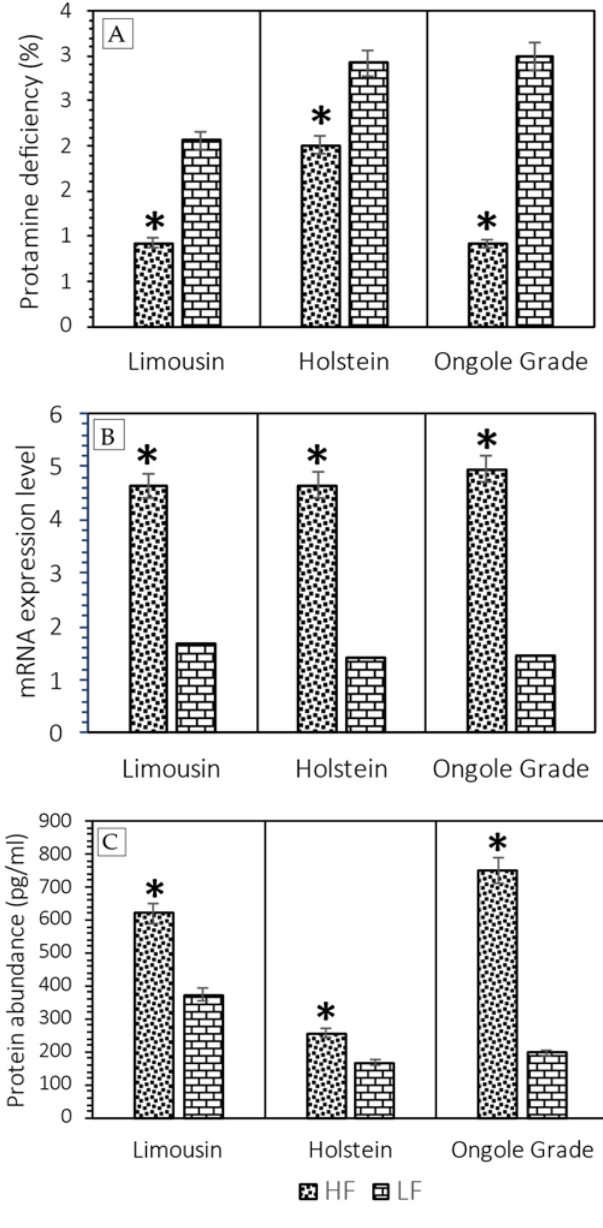
Figure 3. The PRM deficiency (CMA3) percentage ( A ), relative expression of PRM1 gene ( B ), and the abundance of PRM1 protein ( C ) in Limousin, Holstein, and Ongole Grade bulls with different fertility (HF vs. LF). * Significant difference when compared to LF ( p < 0.05). The fertility score (%CR) in each bull breed in the study showed a positive correlation Table 2. Correlation of bull fertility scores with sperm quality parameters, SDF, PRM1 gene, and with semen quality parameters such as PM ( p < 0.01), viability ( p < 0.01), and plasma protein abundance in Limousin, Holstein, and Ongole Grade bulls a . membrane integrity ( p < 0.01) (Table 2). A negative correlation also existed between the Breed Parameter Correlation Coefficient p -Value %CR in all breeds of bull and the level of SDF ( p < 0.01) (Table 2). The research results %CR vs. PM (%) 0.786 <0.000 indicated that high sperm with PRM deficiency correlated closely with a lower %CR in all 0.821 bull breeds ( p < 0.01). Additionally, the results of the PRM1 assessment also confirmed it Limousin at the mRNA and protein levels, with the high relative expression of genes and protein abundance indicating linearity with an increase in the %CR (Figure 4). A close correlation between %CR and PRM1 gene expression ( p < 0.01) and protein abundance ( p < 0.01) was − 0.694 also shown in all bulls (Table